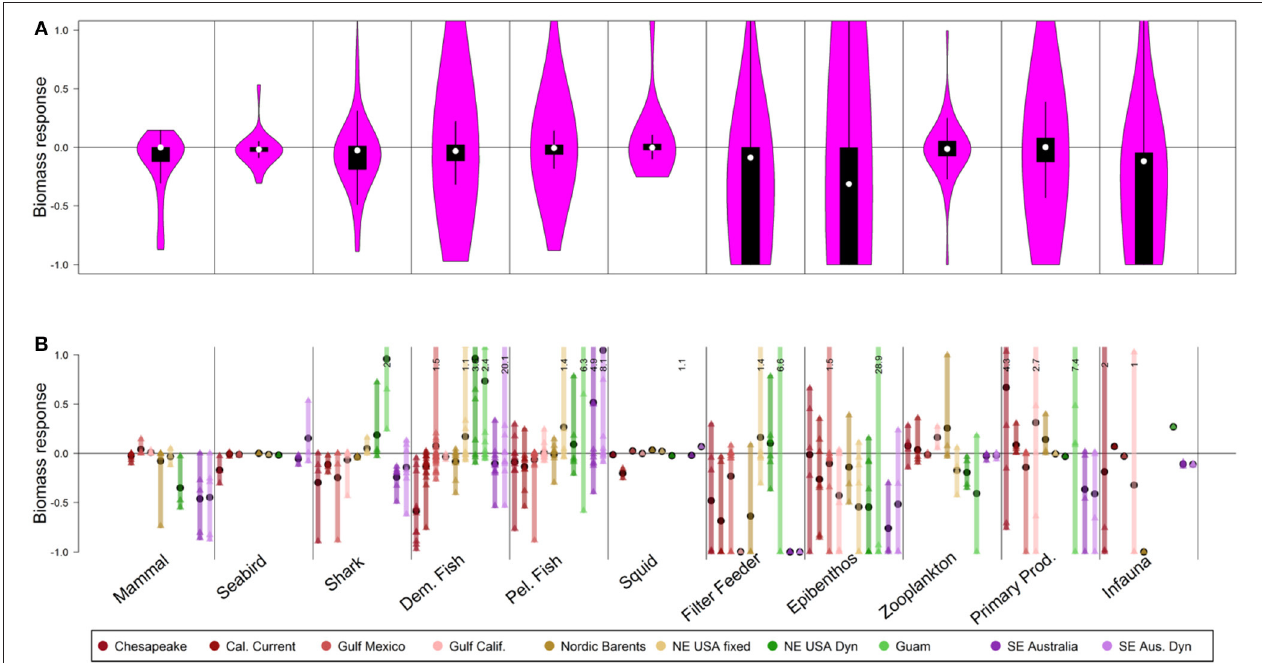
FIGURE 2 | Biomass response of 50-year scenarios of ocean acidification, via an additional 1% mortality rate (day − 1 ) added for selected groups. (A) The shape of the violin plots shows the kernel density of biomass responses across all individual functional groups in all models. Superimposed box plots illustrate the median (white), 5th and 95th percentiles (lines), and first and third quartile (boxes). Functional group responses that exceed 1.0 (i.e., doubling of biomass and the limit of the y-axis) are truncated here, but noted in the lower panel. (B) Detailed results, with each ecosystem model represented by a unique color and ordered as shown in the legend. Vertical bars represent the range of functional group responses, grouped by guilds, within each ecosystem model. Small triangles are individual functional group responses, and black circles are the average responses per model. Functional group responses that exceed a y -value of 1.0 (i.e., doubling of biomass) are indicated with black